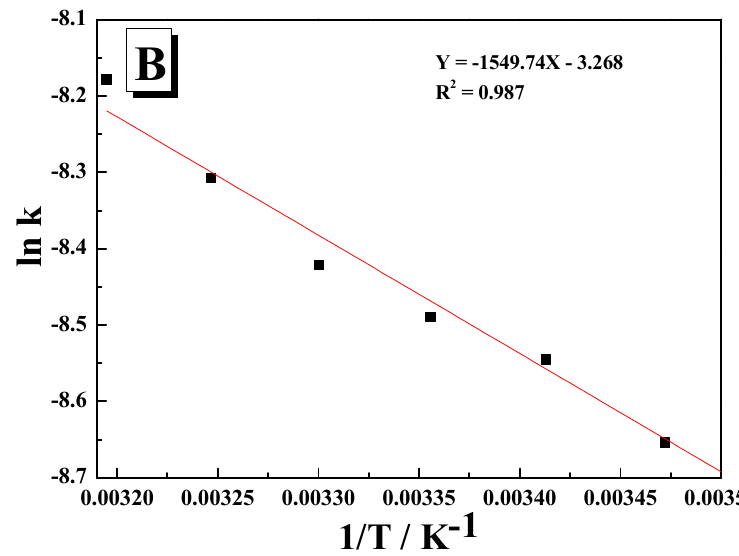
Figure 8. The thermal fading kinetics of: ( A ) Fe(III)-chelated R–PLG 23 metal complexes after UV irradiation for different temperatures ([FeCl 3 ] = 10 − 3 M and [R–PLG 23 ] = 10 − 4 M in THF). Inset: The curves fitted with first-order reaction dynamics ln A = − kt to calculate the thermal bleaching speed constant: k = 1.62 × 10 − 4 s − 1 (10 ◦ C), k = 1.74 × 10 − 4 s − 1 (10 ◦ C), k = 1.94 × 10 − 4 s − 1 (20 ◦ C), k = 2.06 × 10 − 4 s − 1 (25 ◦ C), k = 2.22 × 10 − 4 s − 1 (30 ◦ C), k = 2.47 × 10 − 4 s − 1 (20 ◦ C), k = 2.81 × 10 − 4 s − 1 (40 ◦ C). ( B ) The data were fitted with Arrhenius expressions.